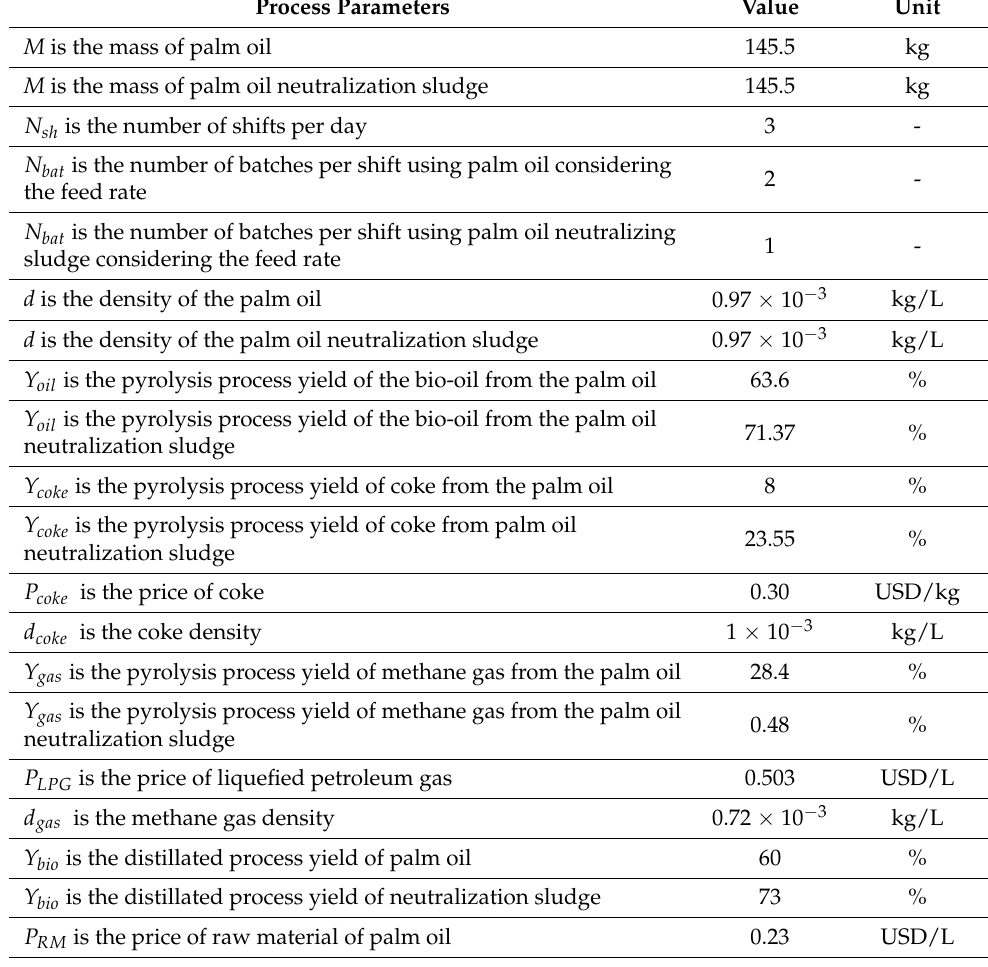
Table 5. Process parameters used in the equations.